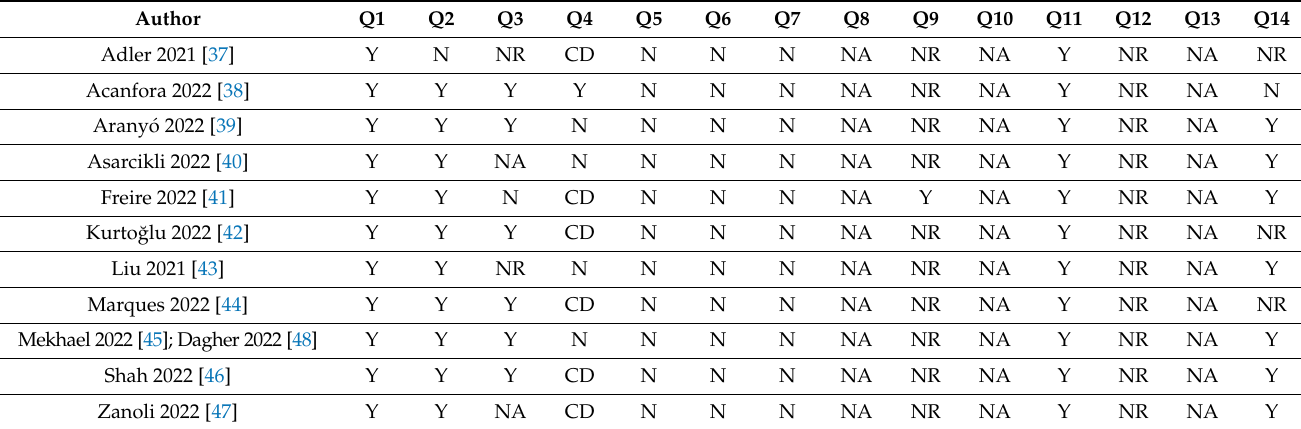
Table 2. Methodological quality of the included